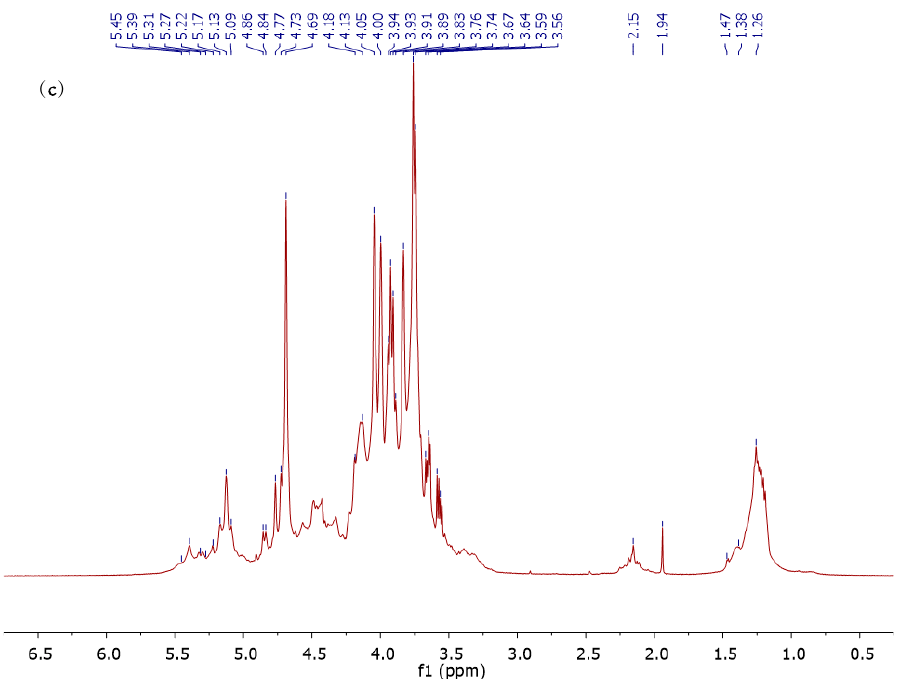
Figure 3. 1 H NMR analysis of alginate (ALCM) ( a ) and fucoidan (FUCCM) ( c ) co-extracted from brow seaweed CM, and ALSM isolated from SM ( b ).